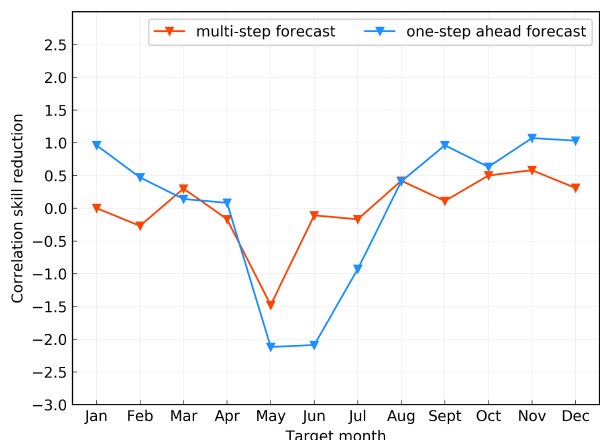
Figure 14. The decline of forecasting skills for ENSO in each target month using the multistep forecast strategy and the one-step-ahead forecast